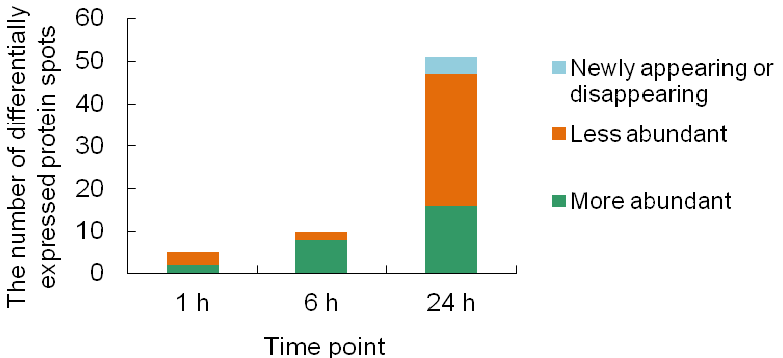
Figure 5. Distribution of protein spots upregulated, downregulated, and newly appearing or disappearing during Cr(VI) treatment.